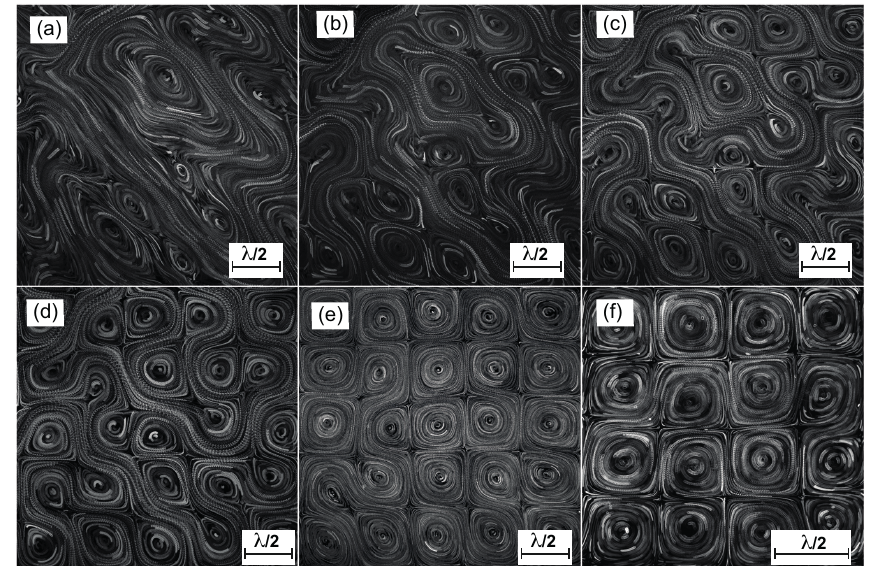
Figure 6. Particle trajectories tracked for 24 periods for waves generated at f = 4.58 Hz, a / λ = 0.1 at ( a ) φ = 0 ◦ , ( b ) φ = 30 ◦ , ( c ) φ = 50 ◦ , and ( d ) φ = 90 ◦ . ( e ) Trajectories measured at f = 4.58 Hz, a / λ = 0.05 and φ = 90 ◦ . Trajectories shown in ( a – e ) were measured on the surface of water. ( f ) Trajectories for waves generated in the glycerol–water solution ( η = 10 mPa · s − 1 ) at f = 3.8 Hz, a / λ = 0.08 and φ = 90 ◦